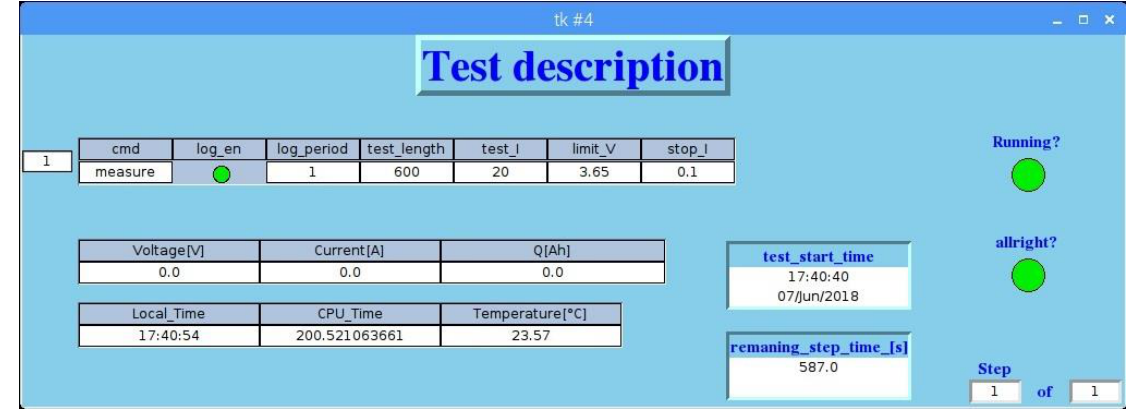
Figure 7. The window opened while the software application is executing the periodic task.